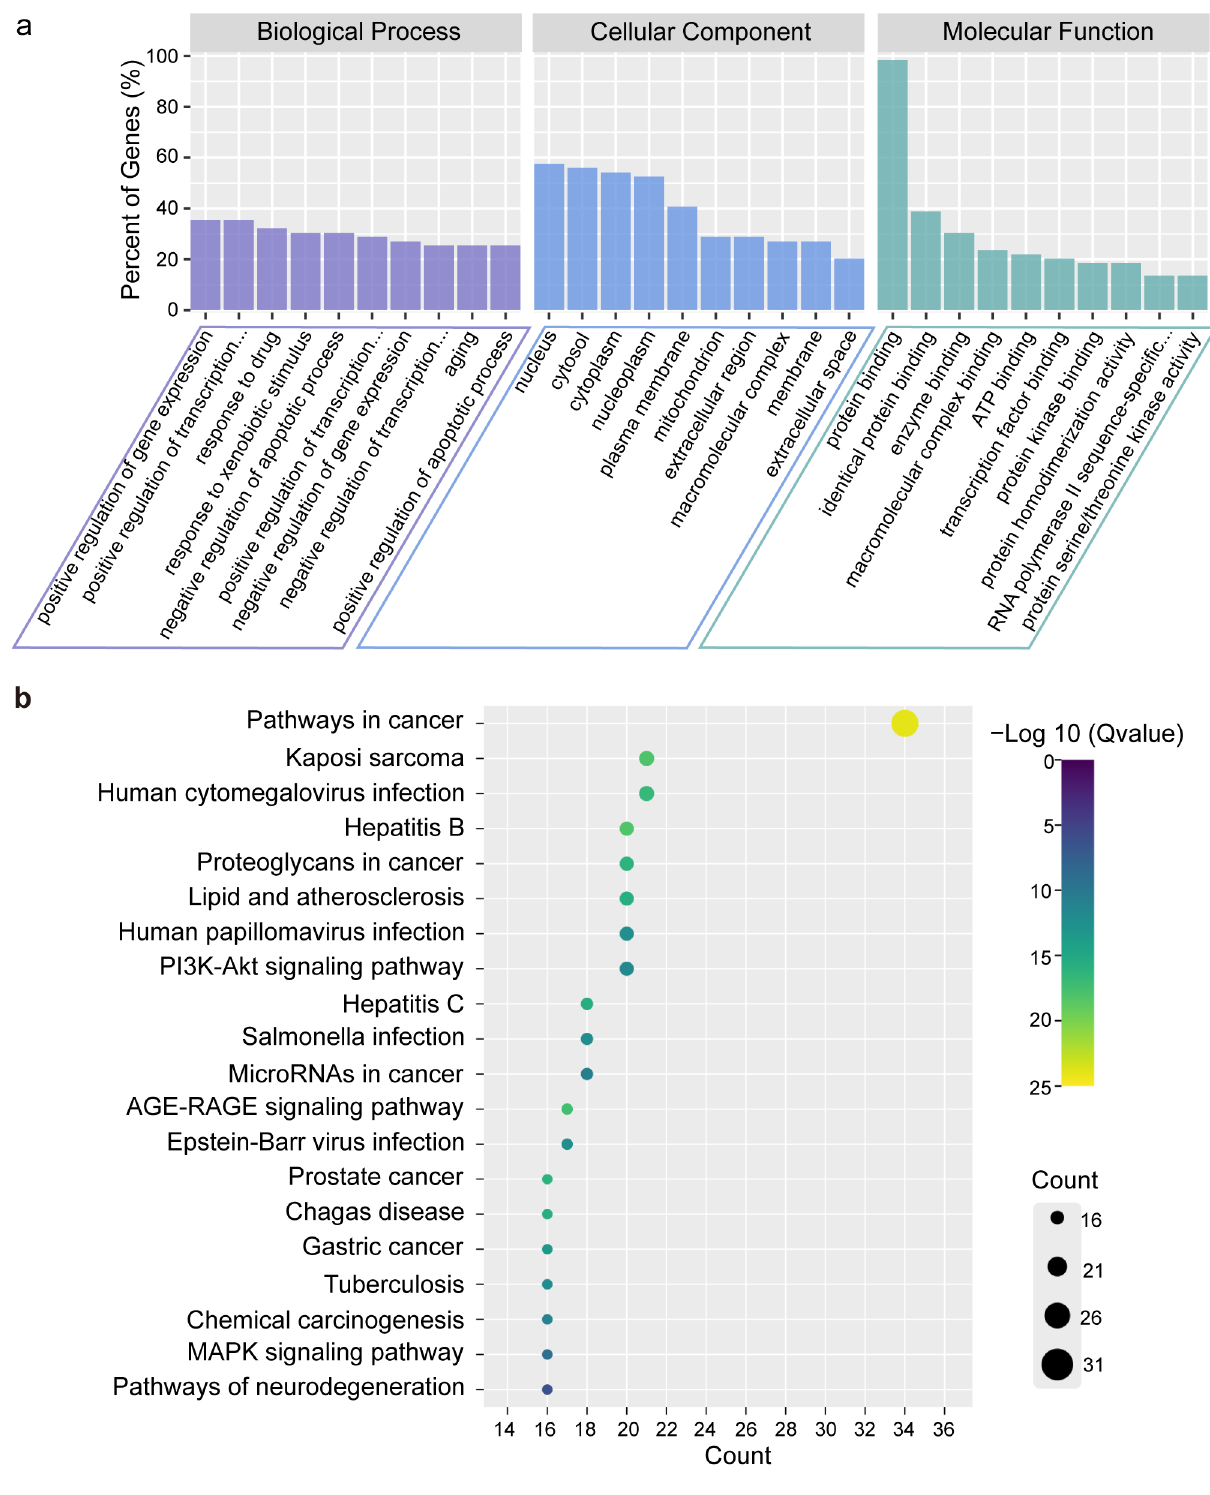
Figure 3. Analysis of GO and KEGG enrichment to identify the anti-tumor mechanisms. ( a ) The top 10 in BP terms, CC terms, and MF terms of the GO terms ( p < 0.05); ( b ) The top 20 KEGG pathways ( p < 0.05).